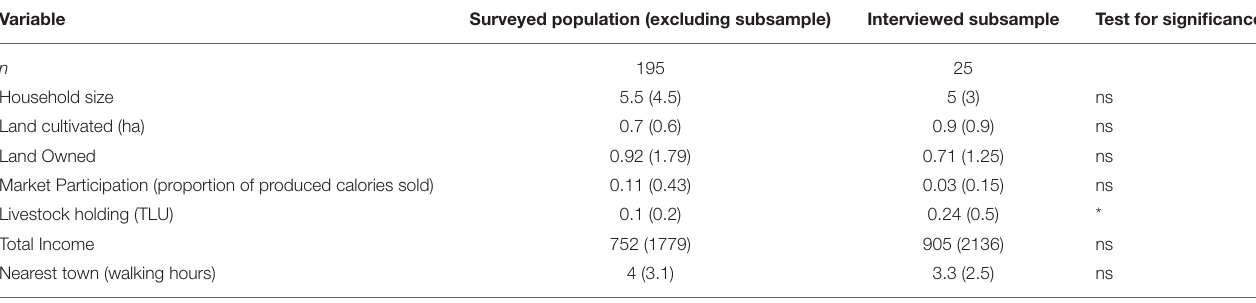
TABLE 2 | Summary statistics for households the dry corridor of Guatemala by interviewed subsample, all values give the median with inter-quartile range in parenthesis. Variable